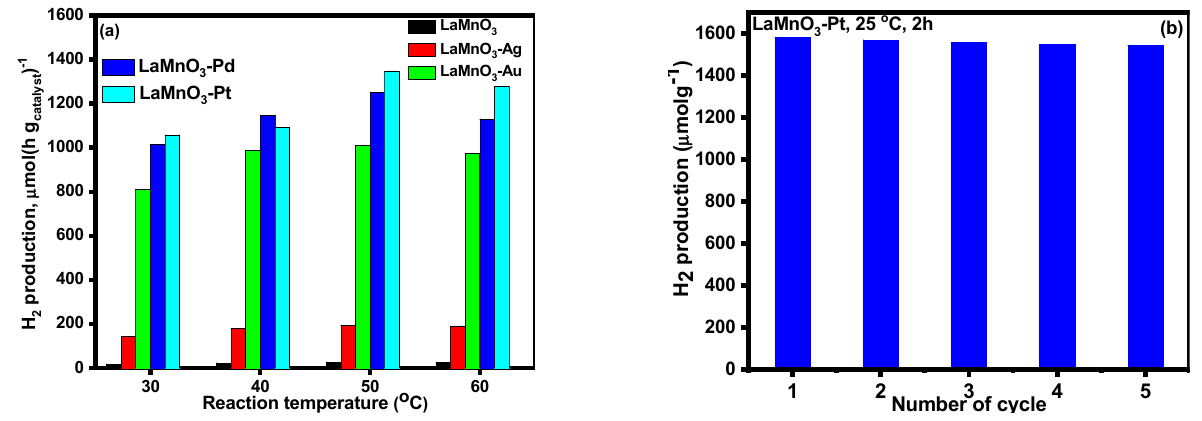
Figure 10. ( a ) Effect of reaction temperature on photocatalytic H 2 production, ( b ) recyclability of the catalyst.